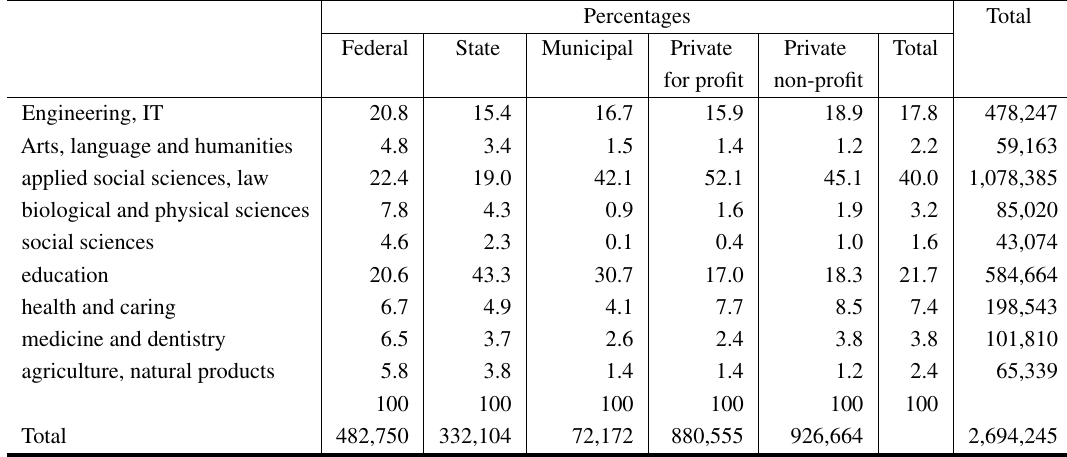
Enrollments in higher education by type of institution and field. Percentages Total Federal State